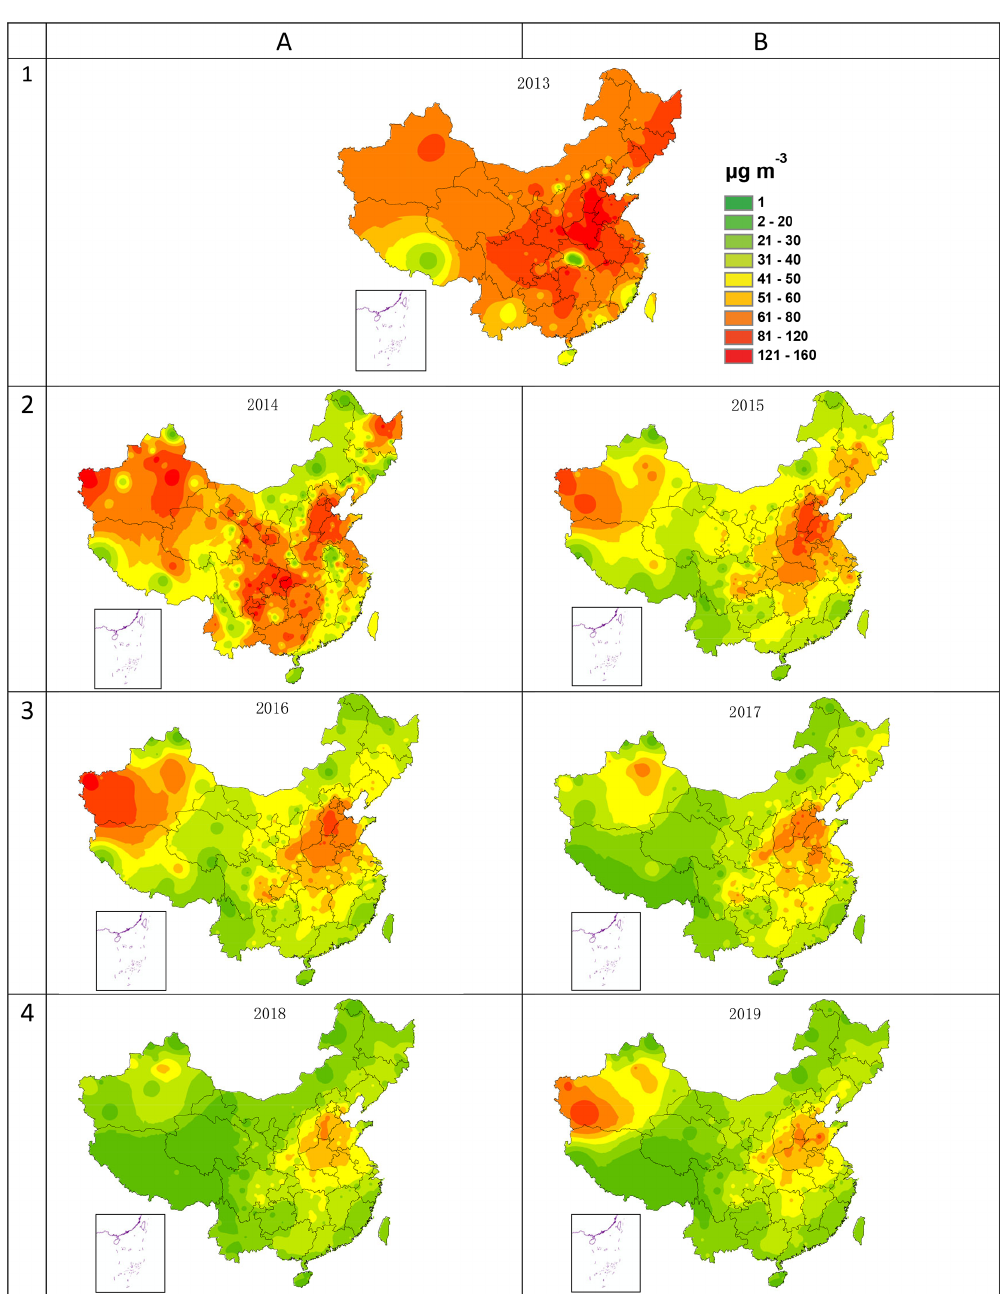
Figure 7. Regional annual PM 2 . 5 concentration distributions from 2013 to